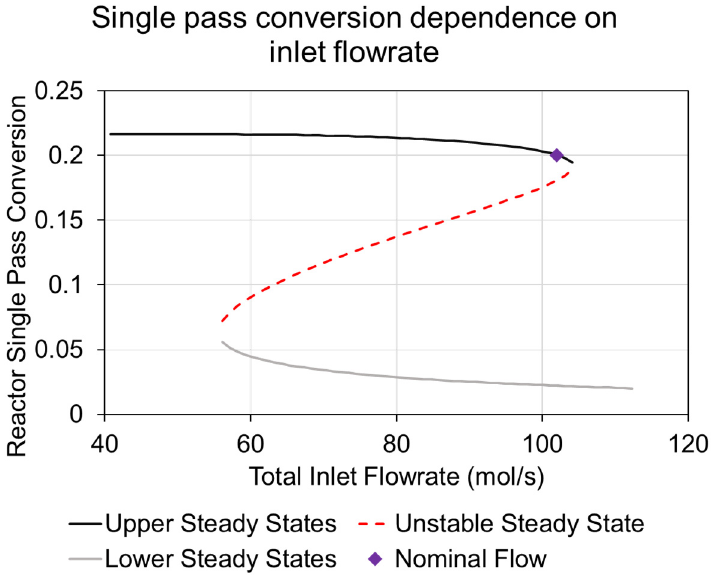
Figure 4. Single pass conversion dependence on the reactor inlet flow rate with the upper and lower steady states displayed. The chart also displays the nominal flow.